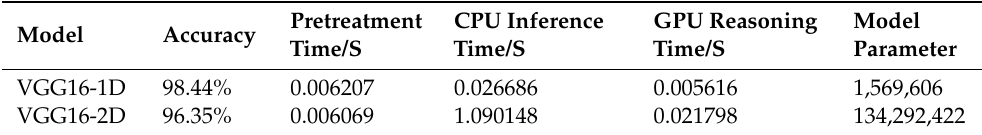
Table 3. Processing time of different models and processors.